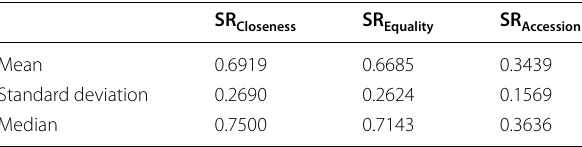
Table 2 Strategy rate